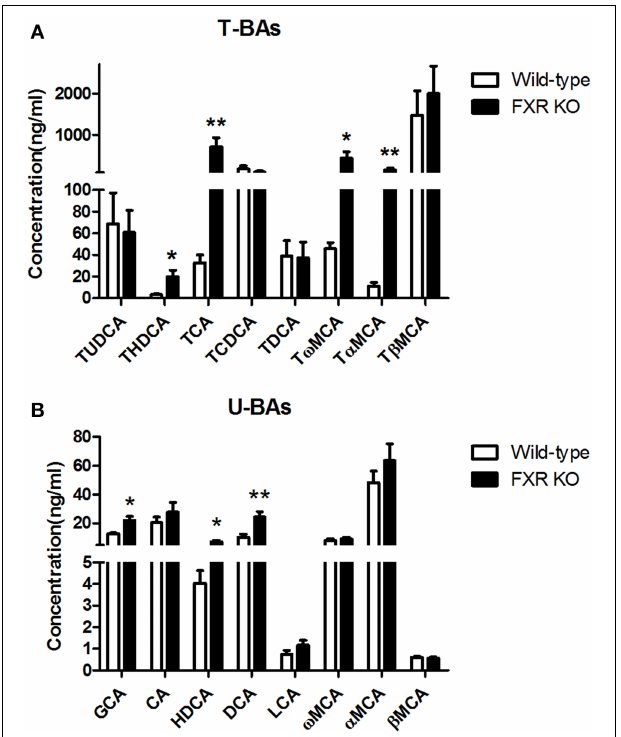
FIGURE 8 | FXR KO on BAs in serum. In comparison with wild-type controls, FXR KO mice showed higher concentrations of THDCA, TCA, T ω MCA, and T α MCA in T-BAs in serum (A) ; higher concentrations of GCA, HDCA, and DCA in U-BAs in serum (B) . N = 16 /group; * p < 0 . 05 ; ** p < 0 . 01 .